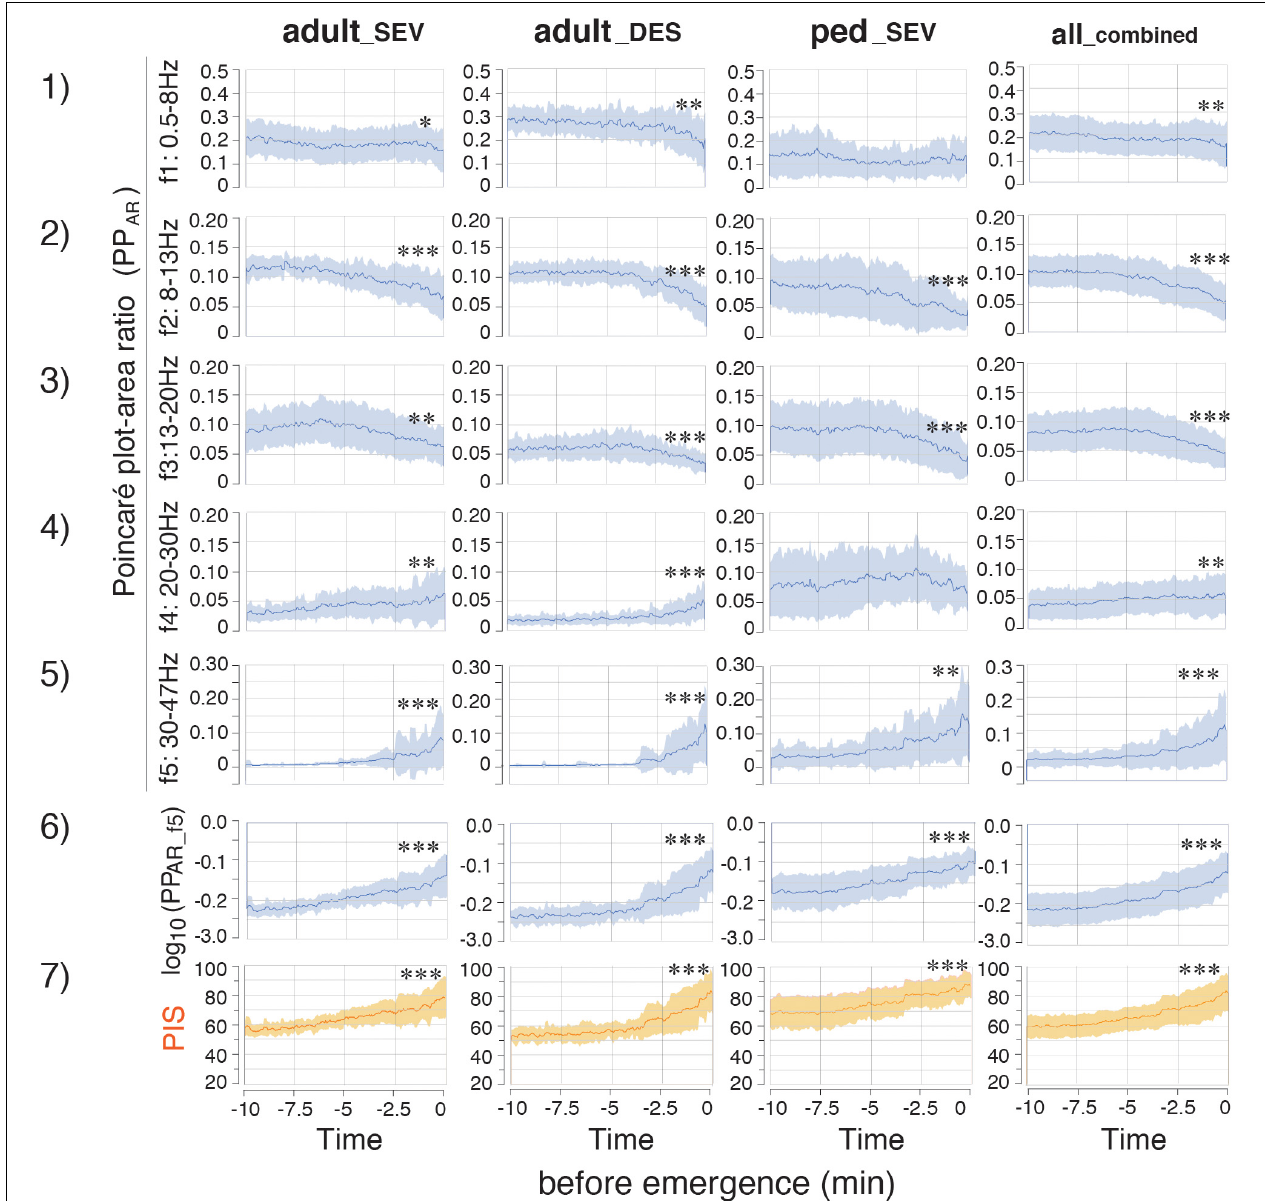
FIGURE 4 | Time-course changes of parameters in the adult _ SEV , adult _ DES , ped _ SEV , and all _ combined groups. (1–5) Plots of the time course of the PP AR (Poincaré plot area of each frequency-range/Poincaré plot area of the f0: 0.5–47 Hz range) throughout the time course from the hypnotic condition to the awake state. (6) log 10 (PP AR _ f 5 ) and PIS. (7) Poincaré plot-integrated score (PIS). PIS = 25 × log 10 (PP AR _ f 5 ) + 112.5. adult _ SEV , adults anesthetized with sevoflurane ( n = 20); adult _ DES , adults anesthetized with desflurane ( n = 20); ped _ SEV , pediatric patients anesthetized with sevoflurane ( n = 20); all _ combined group, all patients from the three groups ( n = 60). Data are shown as mean ± SD. ∗ p < 0.05, ∗∗ p < 0.01, and ∗∗∗ p < 0.001 by Student’s paired t -test between the values at EM - 10 and EM 0 . EM - 10 , 10 min before emergence; EM 0 , at the time of emergence; PP AR , Poincaré plot-area ratio.